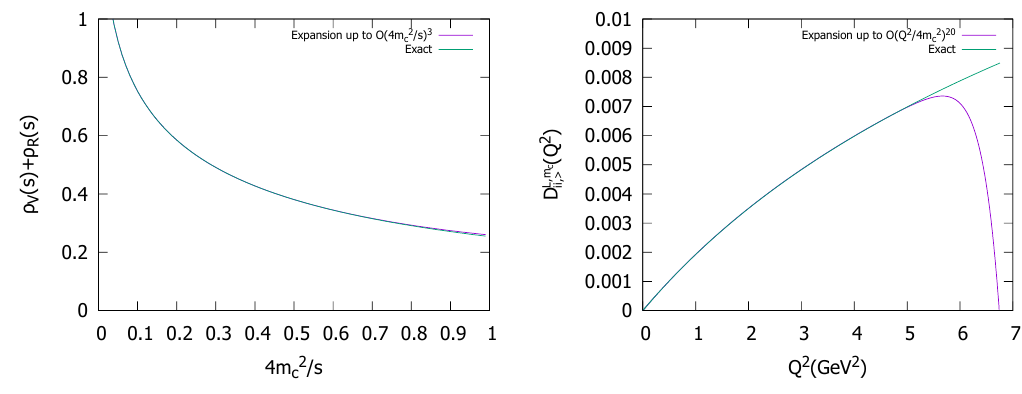
Figure 5 . Left: comparison between the exact form of ρ V ( s ) + ρ R ( s ) and its expansion in the limit 4 m 2 /s → 0 . As can be seen, they are equal for 0 < 4 m 2 c D L,m c ( Q 2 ) computed numerically and computed analytically, using the expansion (3.13) for ρ V ( s )+ ii,> ρ R ( s ) and performing an expansion in Q 2 / 4 m 2 has been